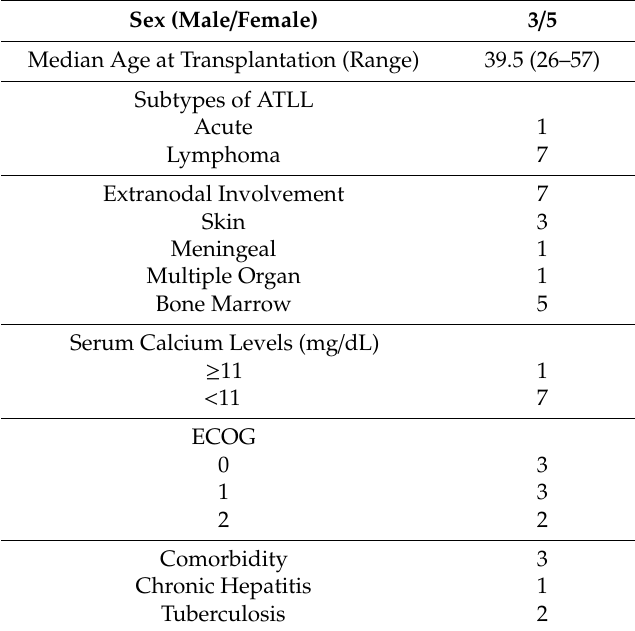
Table 1. Clinical characteristics of